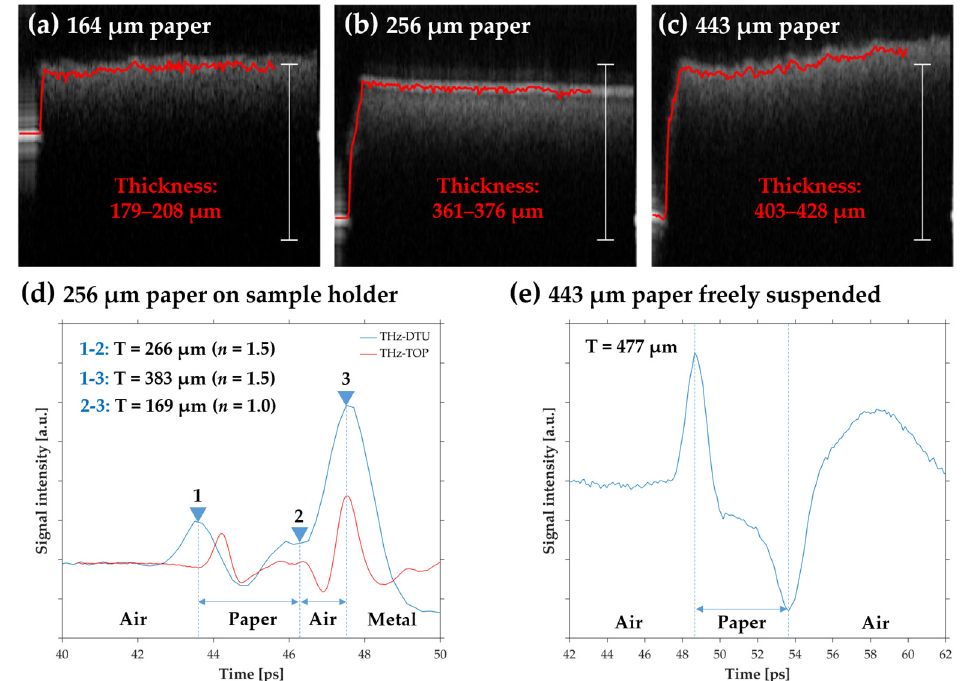
Figure 6. Investigation into the THz overestimation and proof-of-concept demonstration of thickness measurement in freely suspended paper. ( a – c ) OCT thickness measurements using the distance from the sample holder to the paper surface. Scale bars represent 0.5-mm thickness in air. ( d ) Analysis of the 256- μ m paper THz traces indicating presence of an air gap. ( e ) Proof-of-concept demonstration of THz thickness measurement in freely suspended 443- μ m paper sample.